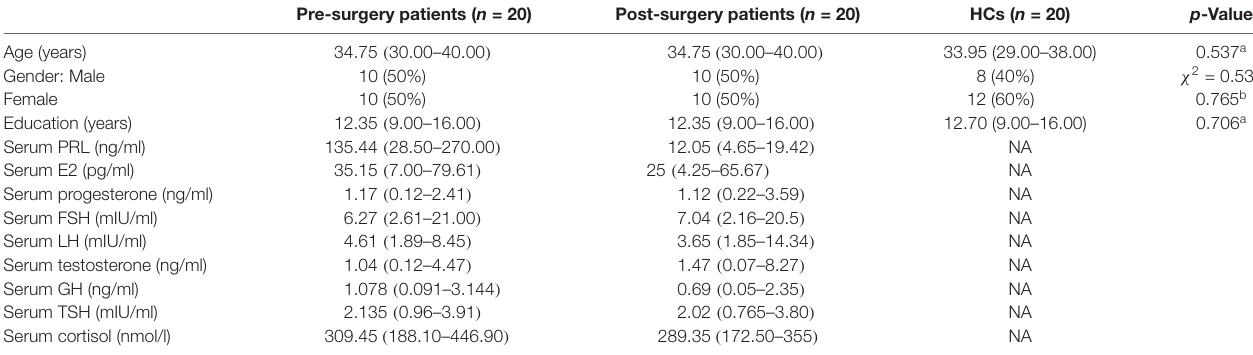
TABLE 1 | Demographic and clinical characteristics: pre- and post-surgery patients, and healthy controls (HCs). Pre-surgery patients ( n = 20)